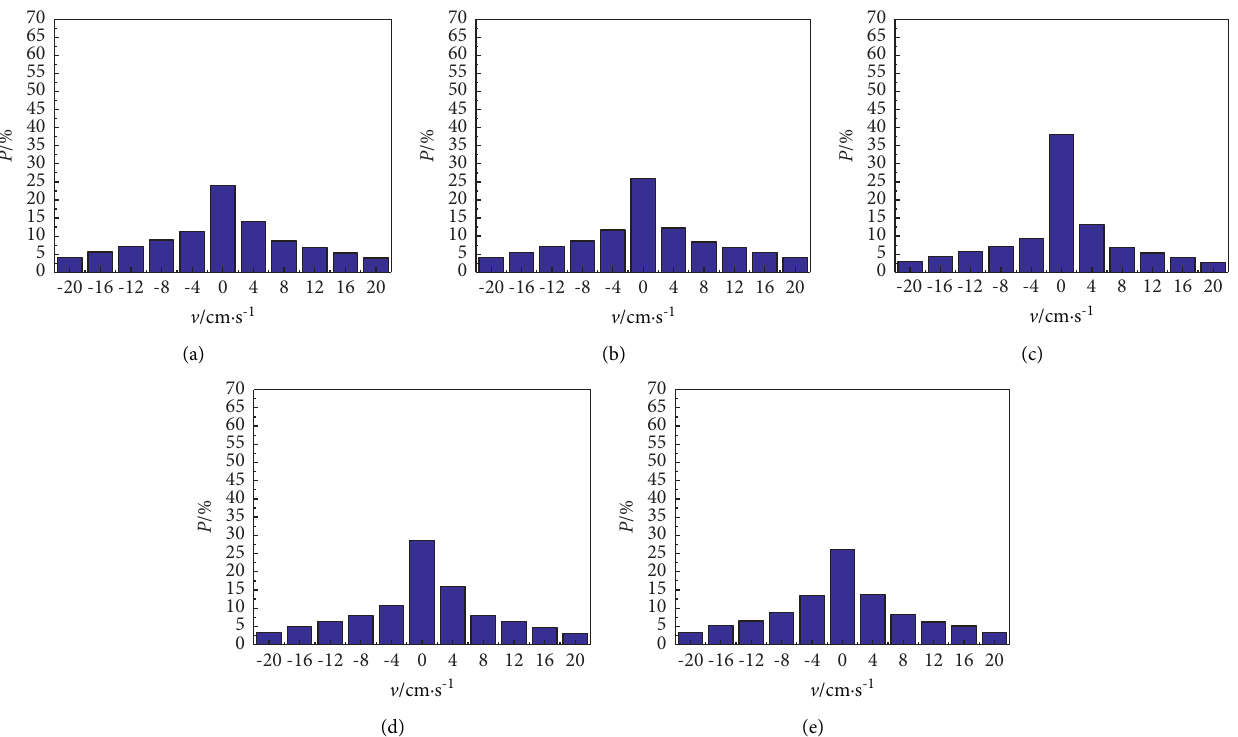
Figure 6: The probability distribution of vertical pulsation velocity in different working conditions. (a) H25-1, (b) H25-1.2, (c) H25-1.5 (D252), (d) D251, and (e)